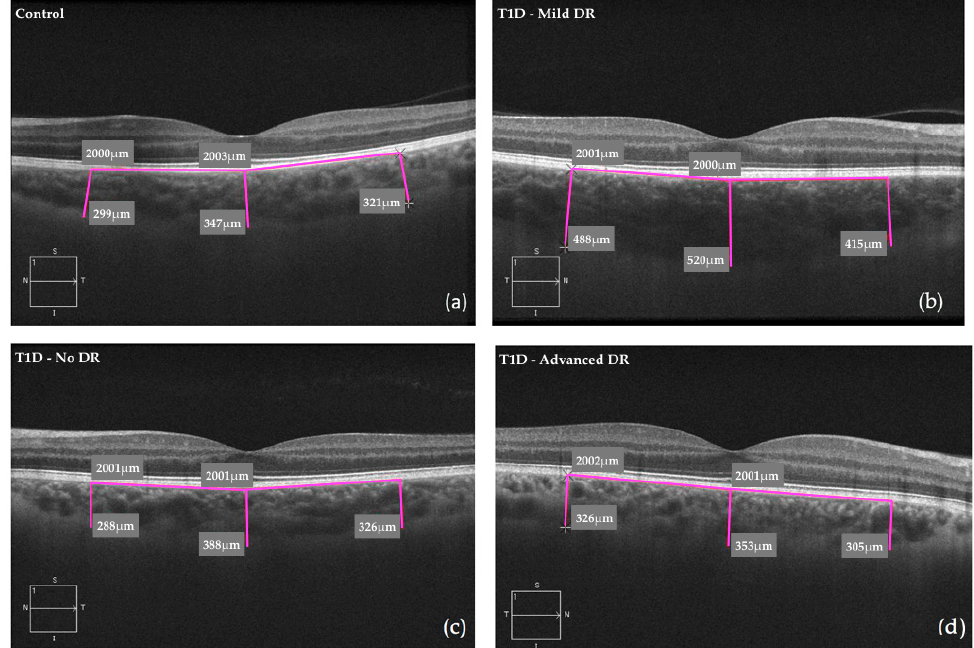
Figure 2. Choroidal measurements by spectral-domain optical coherence tomography: ( a ) control subjects; ( b ) T1D subjects with mild DR; ( c ) T1D subjects without DR and ( d ) T1D subjects with advanced DR. T1D, type 1 diabetes; DR, diabetic retinopathy.